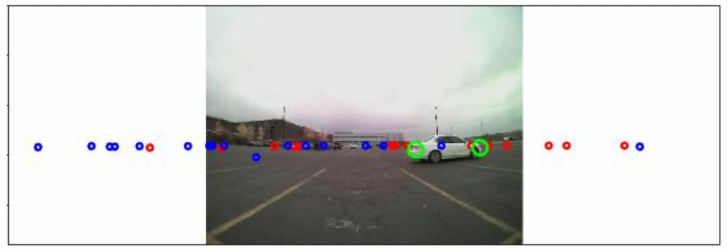
Figure 5. Projected radar points over the corresponding image frame and beyond of the camera image. After the signals from two radars are successfully transformed into the image coor- dinate system, then moving objects can be identified using the range rate information from the radar sensor. The range rate information is useful to identify a moving object. In the proposed RCT detection system, the primary goal is to detect all moving objects with speed > 0.1 m/s (equals to 0.36 km/h), and the range is within a 30 m range. Therefore, valid radar signals have a range value less than 30 m, range rate > 0.1 m/s (equals to 0.36 km/h), and validity level ≥ 1. In Figure 6, the small blue dots represent static objects. The green circles represent the radar signals for moving objects obtained from the left radar. The red circles are the radar signals for moving objects obtained from the right radar.